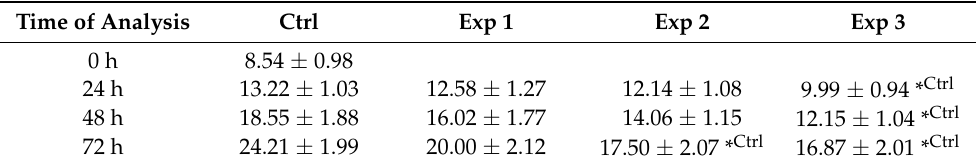
Table 6. DNA fragmentation index of boar spermatozoa (%) exposed to selected semen extenders during different time